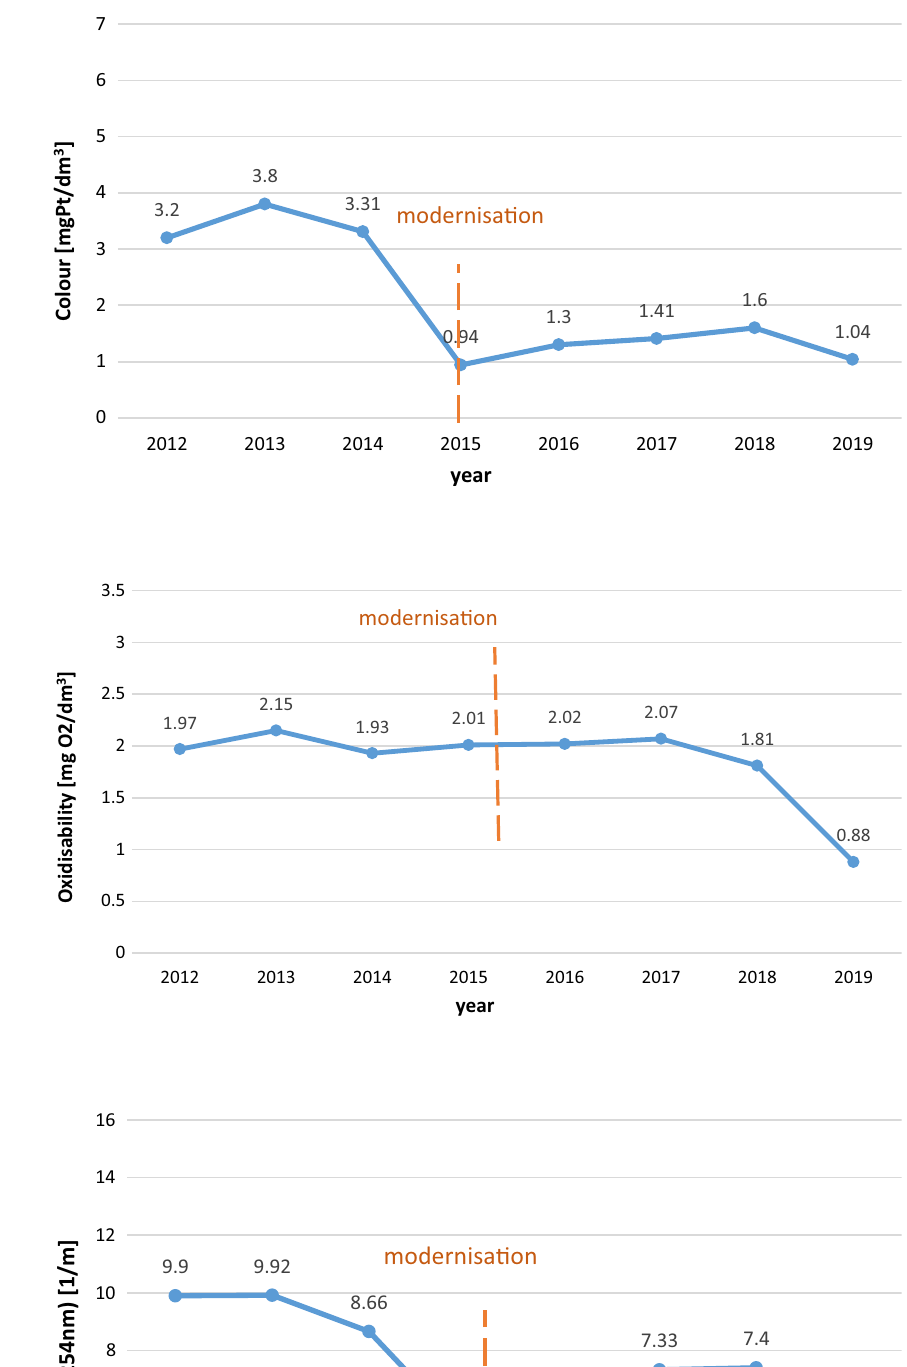
Fig. 5 Average UV absorbance (254 nm) 1/m in treated water